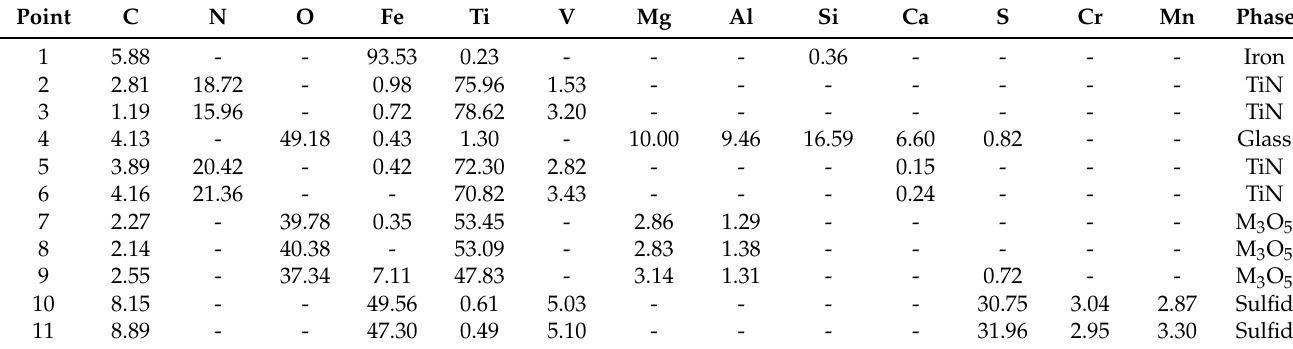
Figure 5. Microstructure and EDS results of the pellets roasted at 1100 ◦ C for 90 min: ( a ) typical SEM image; ( b ) the reduced titanomagnetite; ( c ) the reduced ilmenite; ( d ) V, Ti, N, and Fe elemental maps of the area shown in ( b ). Figure 6 and Table 5 show the microstructure and EDS results of the pellets roasted at 1200 ◦ C. Table 5. Elemental composition of points shown in Figure 6